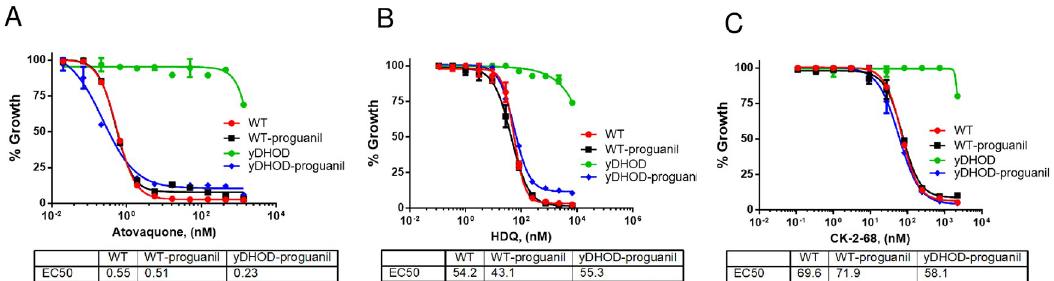
Fig 3. HDQ and CK-2-68 target the bc 1 complex. D10attB-yDHOD transgenic (yDHOD) or wildtype (WT) parasites were challenged with atovaquone (A), HDQ (B) and CK-2-68 (C) with and without proguanil (1 μ M). Growth was measured using 3 H- hypoxanthine incorporation assays. For each compound, a mean EC 50 value is shown at the bottom of each panel for WT parasites (with or without proguanil) and yDHOD parasites treated with proguanil. (Note, EC 50 values are not valid in yDHOD parasites when the parasites are fully resistant to compounds in test.) Data shown is a representative of n = 3 replicates. Error bars show standard deviations of three technical replicates in the representative